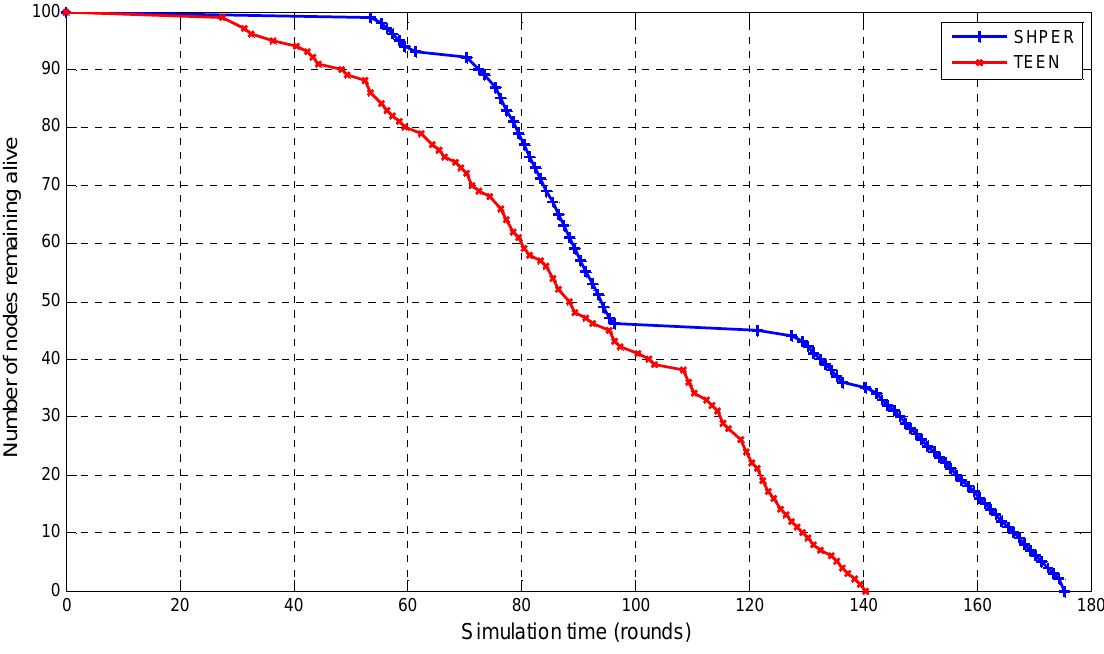
Figure 5. Comparative depiction of the nodes remaining alive over the simulation time steps in SHPER and TEEN, [ Er (0) = 0.5 J, D = 200 m]. i